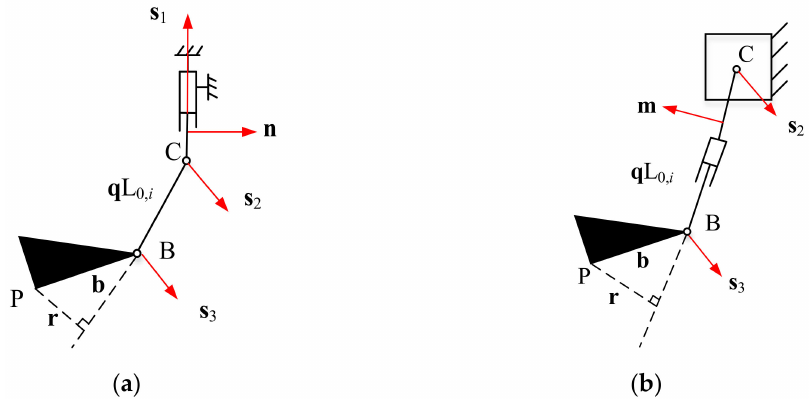
Figure 3. Two types of driving chain. ( a ) PRR-type driving chain; ( b ) RPR-type driving